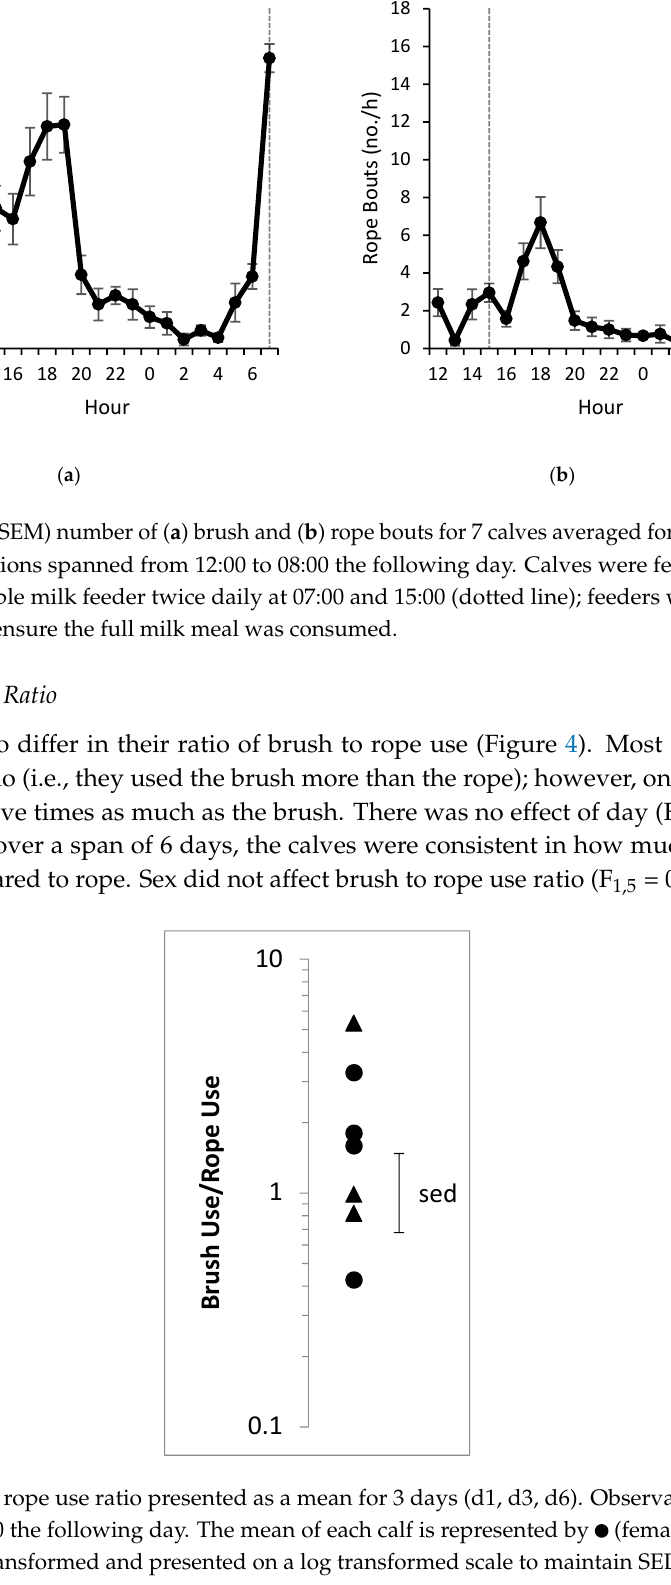
Figure 2. Mean (± SEM) time spent using ( a ) brush and ( b ) rope for 7 calves averaged for 3 days (d1, d3, and d6). Observations spanned from 12:00 to 08:00 the following day. Calves were fed 4 L of whole milk from a 5-nipple milk feeder twice daily at 07:00 and 15:00 (dotted line); feeders were left in the pen for 30 min to ensure the full milk meal was consumed.